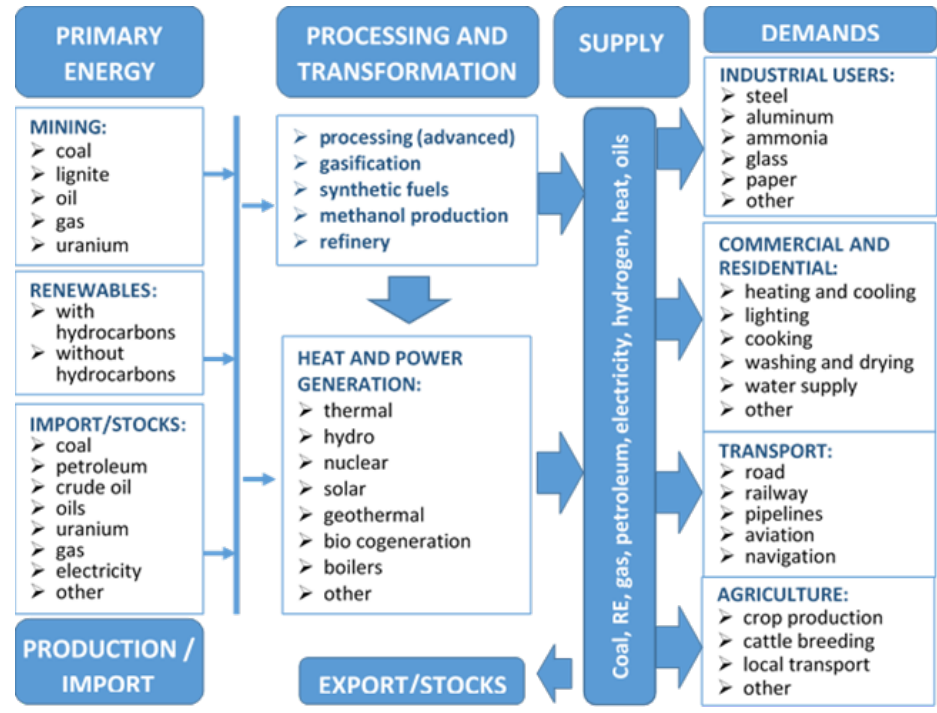
Figure 1. Main structural components of the TIMES-Ukraine model [45].